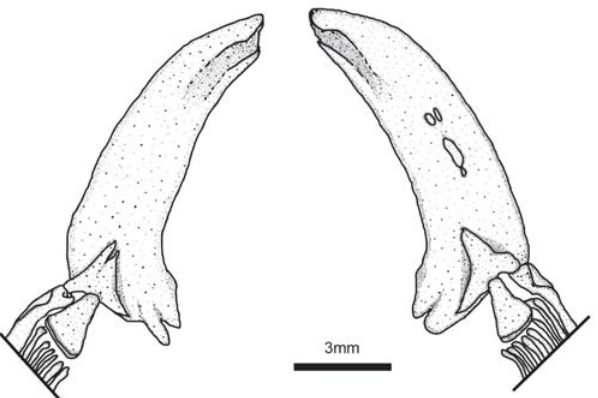
Fig. 5. Ventral view of the pectoral girdle in Trichomycterus igobi , MPEG 13354, paratype.